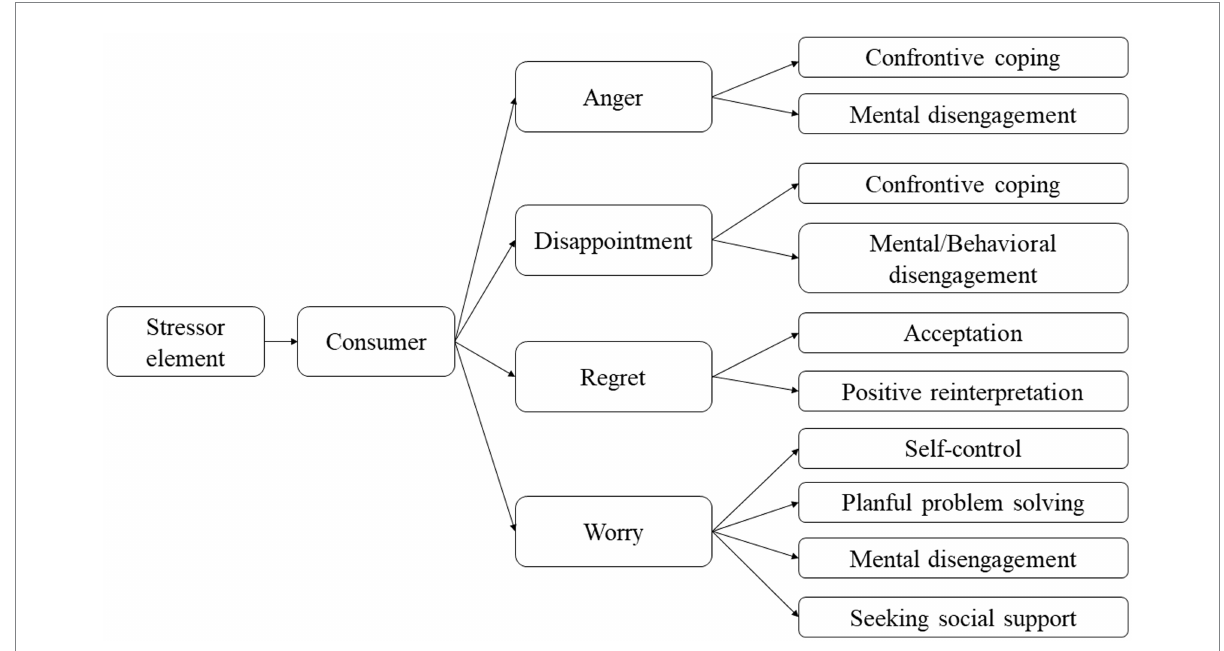
FIGURE 2 Consumers’ coping strategies. Drawn using source data from Yi and Baumgartner